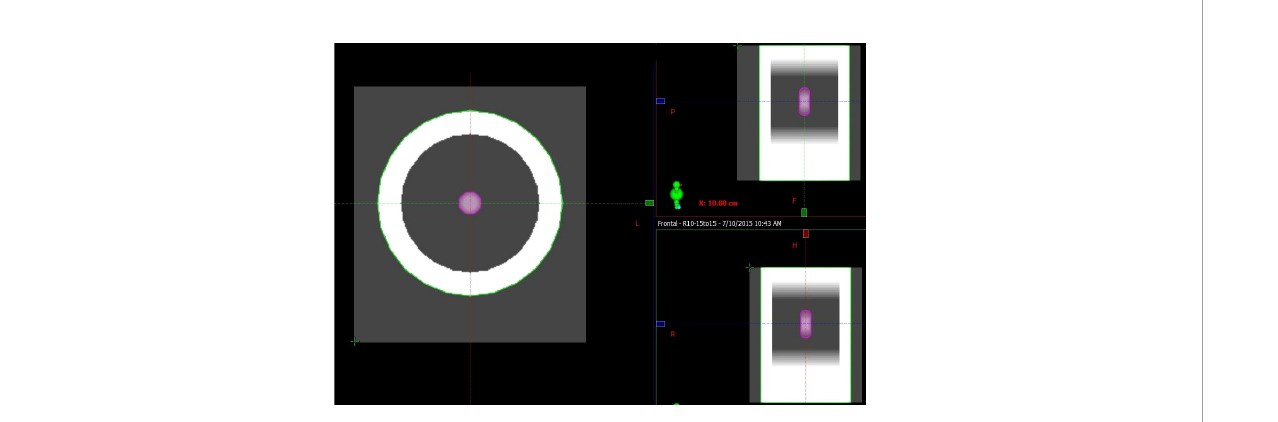
FIGURE 1 Example of AVG CT of a respiratory digital lung cancer phantom. The ITV contoured in the MIP (pink contour), chest wall (green contour) and lung (between the tumor and chest wall) are